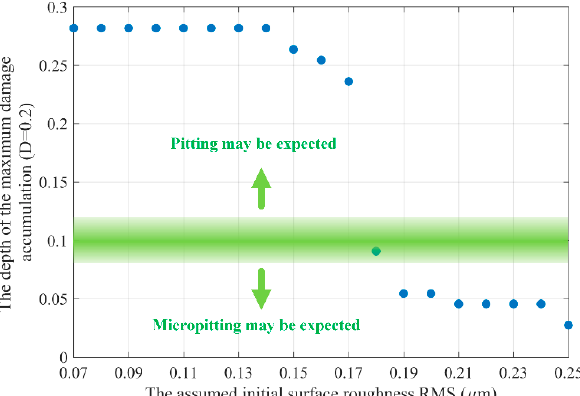
Figure 19. The depth of the maximum damage accumulation (when D = 0.2) of different initial surface roughness values [104].